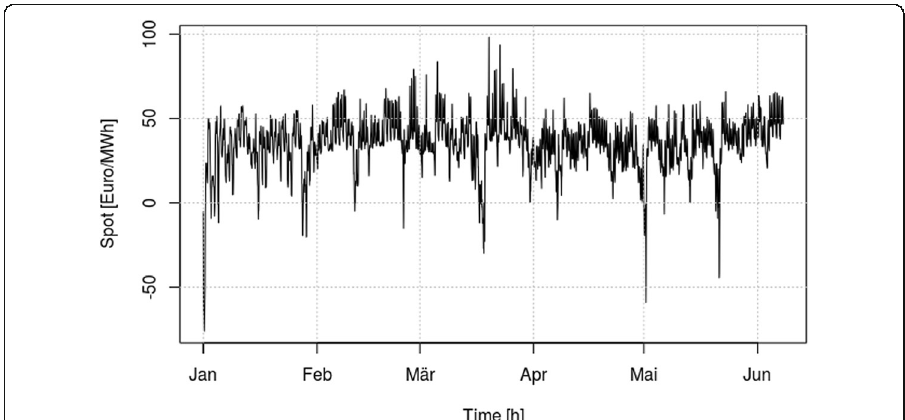
Fig. 1 Time series of German day-ahead prices in